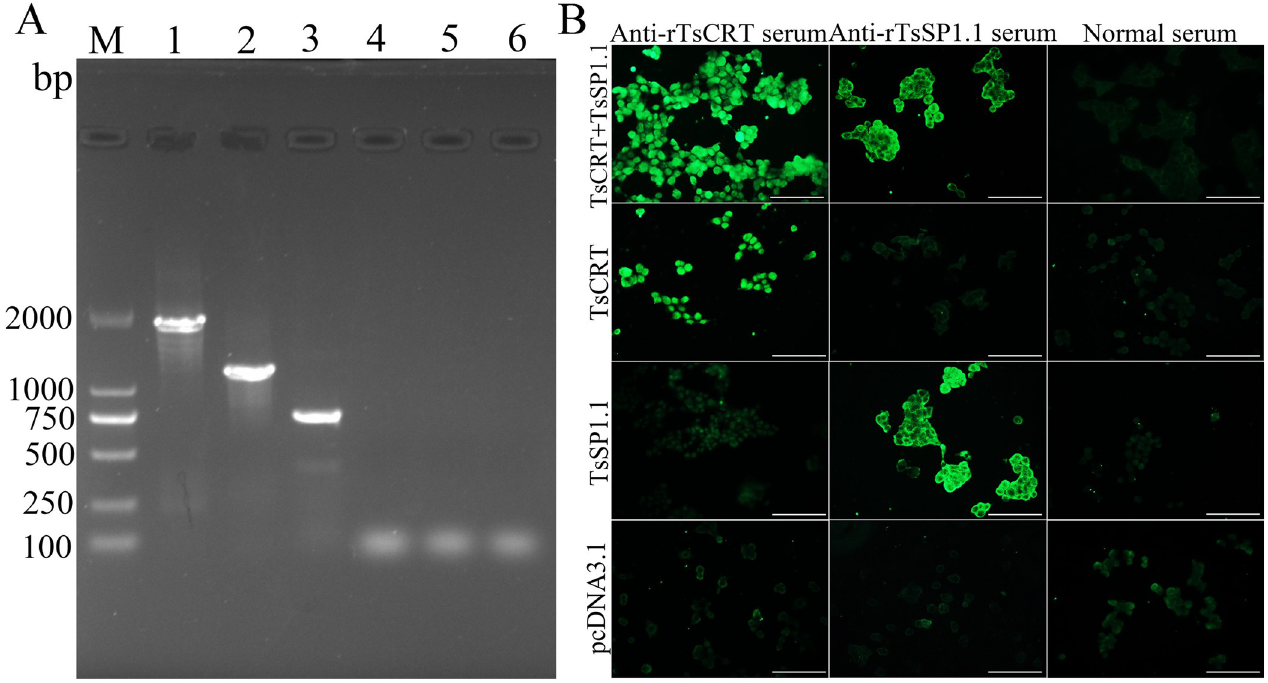
Fig 3. The in vitro transcription and expression of TsCRT+TsSP1.1, TsCRT and TsSP1.1. A: Transcription of TsCRT+TsSP1.1, TsCRT and TsSP1.1 in 293T cells were analyzed by RT-PCR. Lane M: DNA marker. Lane 1: pcDNA3.1-TsCRT+TsSP1.1 transfected cells. Lane 2: pcDNA3.1-TsCRT transfected cells. Lane 3: pcDNA3.1-TsSP1.1 transfected cell. Lane 4: only pcDNA3.1 transfected cells amplified by TsCRT+TsSP1.1 primers. Lane 5: pcDNA3.1 transfected cells amplified by TsCRT primers. Lane 6: pcDNA3.1 transfected cells amplified by TsSP1.1 primers. B: Protein expression of TsCRT+TsSP1.1, TsCRT and TsSP1.1 in transfected cells was detected by IIFT using with anti-rTsCRT serum and anti-rTsSP1.1 serum, but not in only pcDNA3.1- transfected cells. Scale bar: 200 μ m.